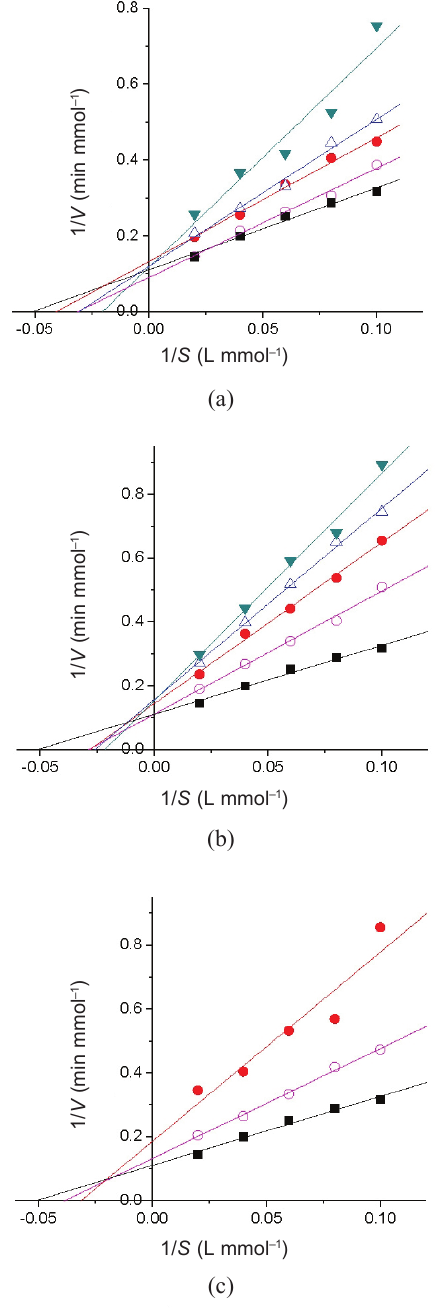
Fig. 3 – Kinetic studies of free CCA with inhibitors: (a) Effect of a weak-acid sodium salt with the addition of 50 mmol L –1 acetate (open triangle), 100 mmol L –1 acetate (solid triangle), 50 mmol L –1 bicarbonate (open circle), 100 mmol L –1 bicarbon- ate (solid circle) and no inhibitor (square); (b) Effect of a weak base with addition of 50 mmol L –1 glucosamine (open triangle), 100 mmol L –1 glucosamine (solid triangle), 50 mmol L –1 etha- nolamine (open circle), 100 mmol L –1 ethanolamine (solid circle) and no inhibitor (square); and (c) Effect of product 7-ACA with the addition of 2 mg mL –1 7-ACA (open triangle), 3 mg mL –1 7-ACA (solid triangle) and no inhibitor (square)